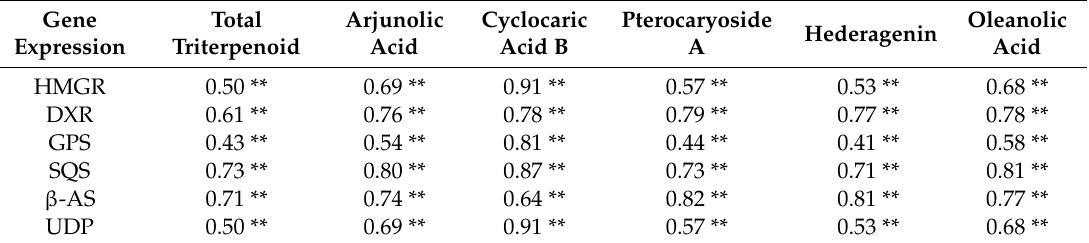
Table 2. Pearson correlation coe ffi cients ( r value) between triterpenoid content and gene expression in the leaves across the nitrogen treatment periods ( n =